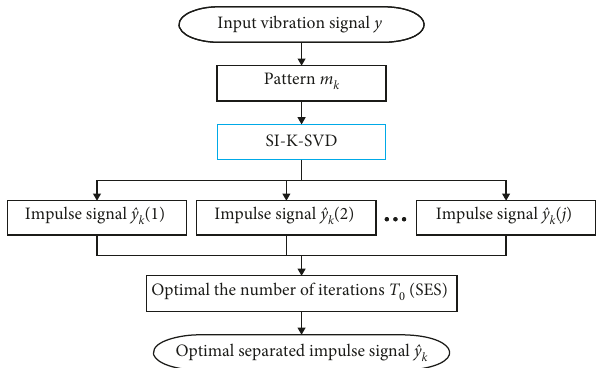
Figure 3: Selection of the number of iterations T SES values for the different number of iterations; (b) extracted impulsive components.